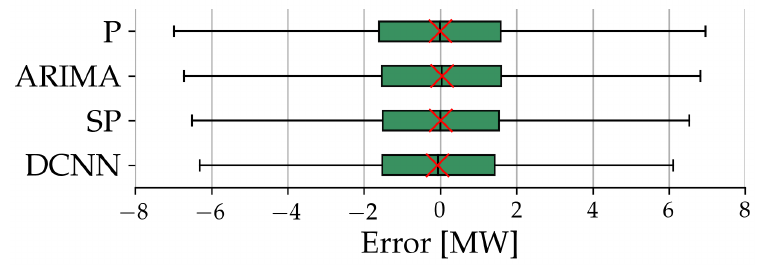
Figure 11. Box-plot histograms of the forecast residuals. The boxes show the median, 25th and 75th percentile. The whiskers indicate the fifth and 95th percentiles. The red crosses indicate the mean of the distribution.